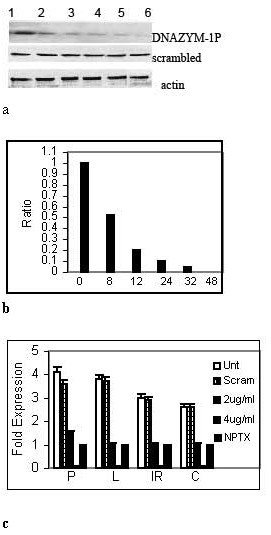
a Western blots with RPS2 antibodies of crude cell extracts from PC-3ML cells following treatment with (top lane) 20 nM DNAZYM-1P for increased times of (lanes 1–6) 0, 8, 12, 24, 32 and 48 hr, respectively. Control cells were treated for identical times with (middle lane) 20 nM scrambled oligonucleotide. (bottom lane) beta actin antibody blots. 2b. Comparisons of the ratio of RPS2/actin from densitometry scans of the Western blots in fig. 2a. 2c. RT-PCR assays showing the relative level of RPS2 expression in (P) PC-3ML; (L) LNCaP; (IR) pBABE-IBC-10a-c-myc; and (C) CPTX-1532 cells (at 90% confluent) which were (□) untreated or treated with (╪) scrambled oligonucleotide, and (░) 2 and (■) 4 ug/ml DNAZYM-1P for 8 hr. Shows that the DNAZYM-1P knocks out RPS2 mRNA expression in all 4 cell lines. (×) NPTX-1532 express low levels of RPS2 mRNA (value set at 1). RT-PCR vales were normalized relative to 18S RNA, and then the fold expression calculated relative to values for untreated NPTX-1532 cells which were set at 1. Results averaged from 3 experiments +/-1 S.D.